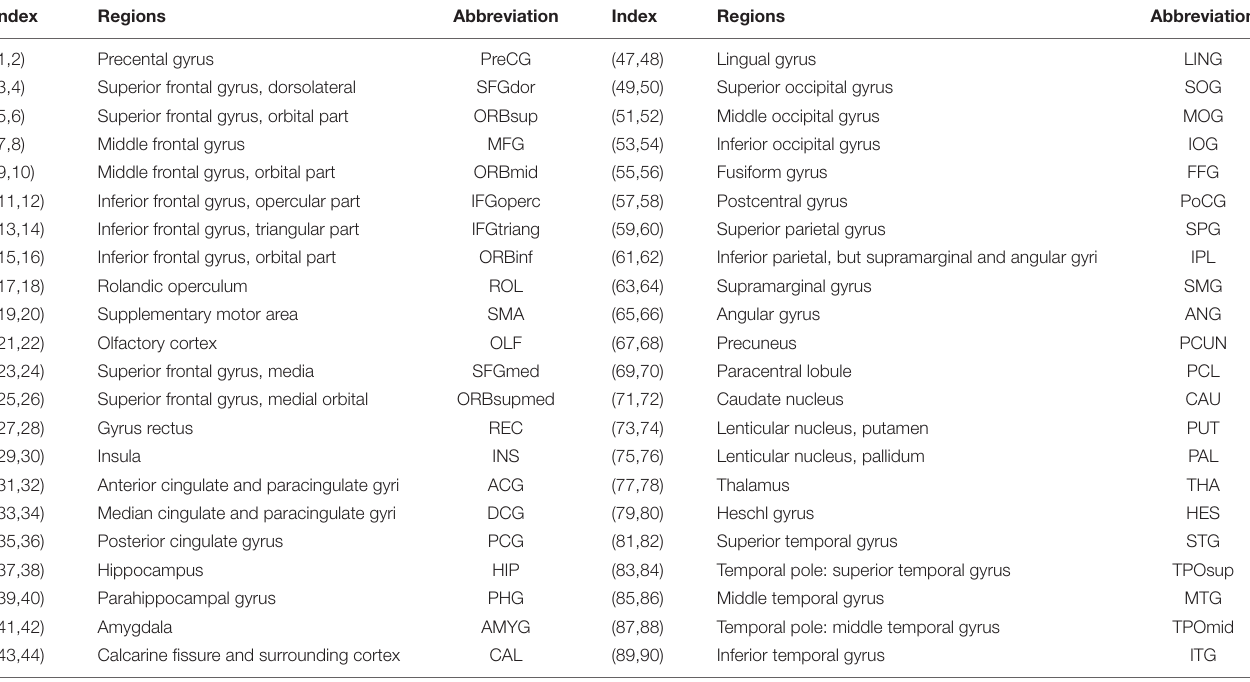
TABLE 1 | The regions are listed in terms of a prior template of the automated anatomical labeling